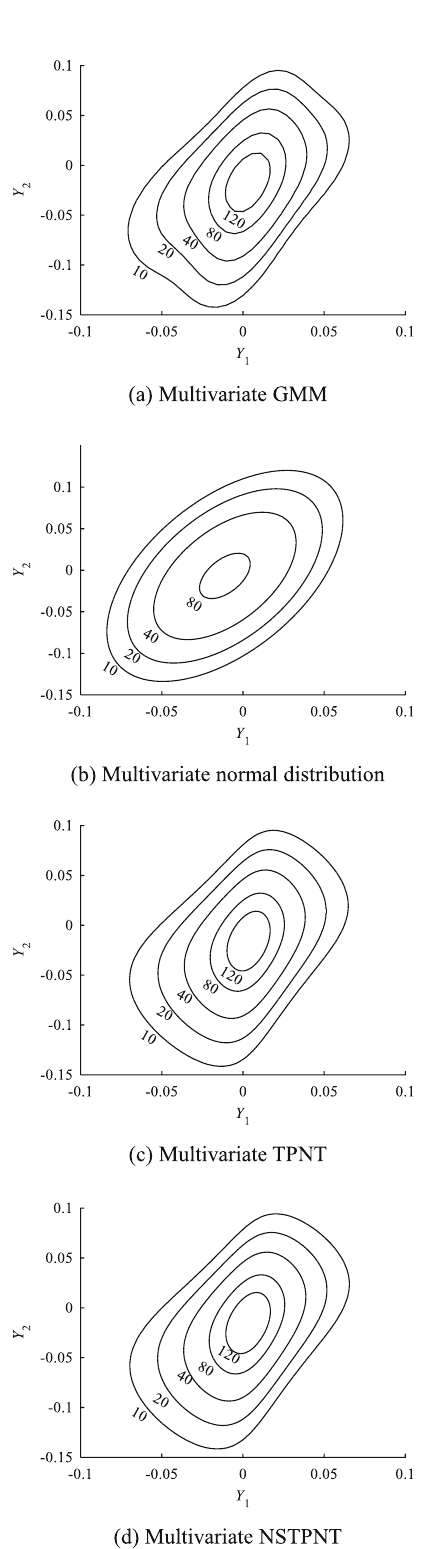
Fig. 6 Comparison of the contours of correlated